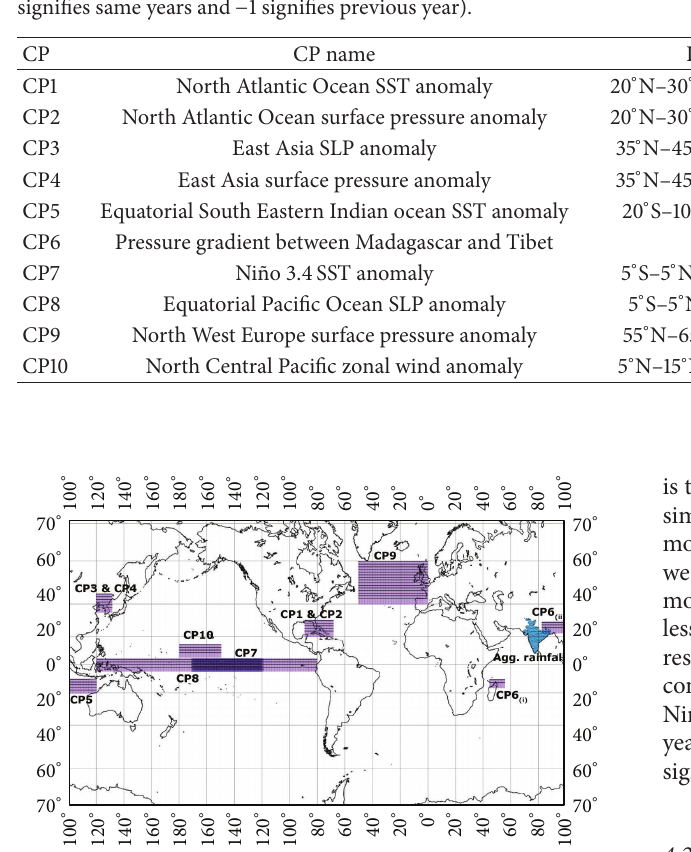
Figure 1: Climatic parameters over the globe governing Indian monsoon (purple patches signify the location of climatic parameters taken, and blue patch represents the Indian region); CP 𝑖 represents parameter 𝑖 in Table 1. Table 2: Predictor sets with climatic parameters. Predictor sets Climatic